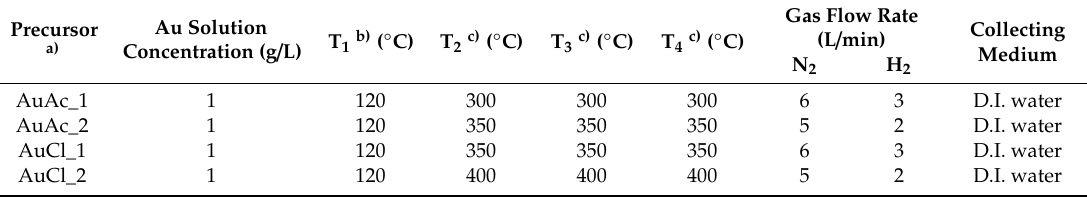
Table 1. Parameters used in Ultrasonic Spray Pyrolysis (USP) synthesis.